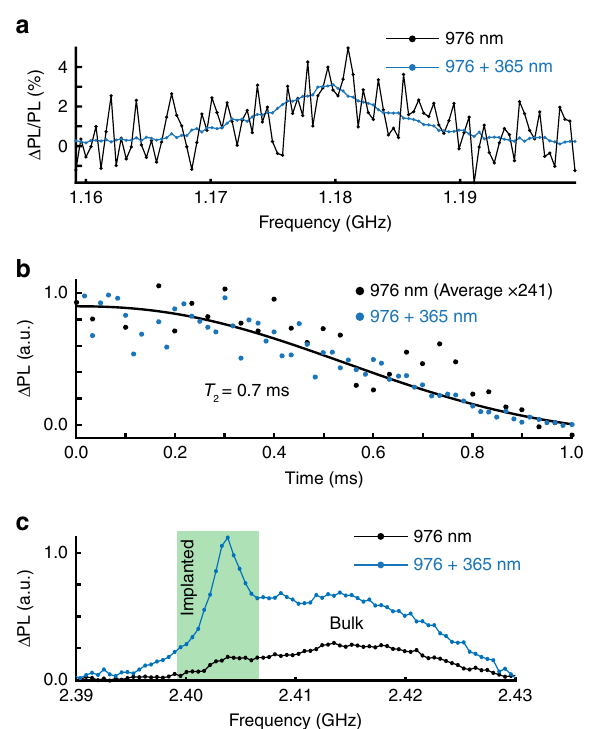
Fig. 2 Charge conversion effect on the spin properties. ODMR signals are given as relative photoluminescence intensities ( Δ PL) under microwave excitation. a CW-ODMR spectrum at 50 G and measured through a monochromator at the 1130.6 nm PL2 zero-phonon line to ensure no other contribution in the optical signal. The intensity is given as the ratio (i.e., contrast) between the ODMR and PL intensity, which remains constant with and without 365 nm illumination, indicating unchanged spin polarization and readout mechanisms. b Hahn echo decay experiment for PL2 at ≈ 400 G, measured with pulsed-ODMR at 6 K. The 365 nm excitation is continuous throughout the sequence, resulting in a signal increase while the coherence time is unaffected. Decay with 976 nm excitation only was averaged 241 times more than the decay with also 365 nm illumination. Line (in black) is a stretched exponential fi t (stretch factor ≈ 2) to the data. c CW-ODMR (PL2 at ≈ 400 G) of a 4H-SiC sample with a 500 nm carbon-implant layer below the surface. The divacancies created at the layer are barely visible before 365 nm excitation. The implanted layer peak is also shifted from the bulk due to a magnetic fi eld gradient across